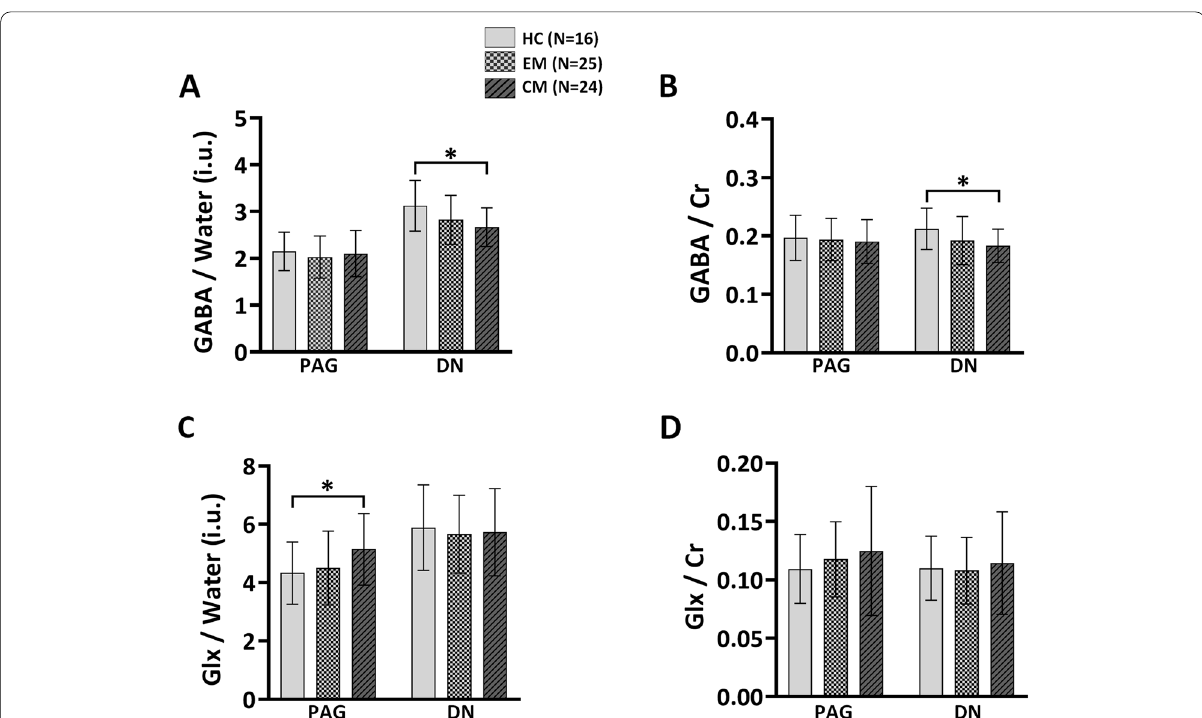
Fig. 3 Brain neurochemical levels of the HC, EM, and CM groups. a GABA/water (international units [i.u.]) in the PAG and DN of the HC, EM, and CM groups. b GABA/Cr in the PAG and DN of the HC, EM, and CM groups. c Glx/water (i.u.) in the PAG and DN of the HC, EM, and CM groups. d Glx/Cr in the PAG and DN of the HC, EM, and CM groups. * P < 0.05 (statistically significant). Abbreviations: HC, healthy control; EM, episodic migraine; CM, chronic migraine; PAG, periaqueductal gray; DN, dentate nucleus; Cr, creatine; GABA, gamma-aminobutyric acid; Glx,